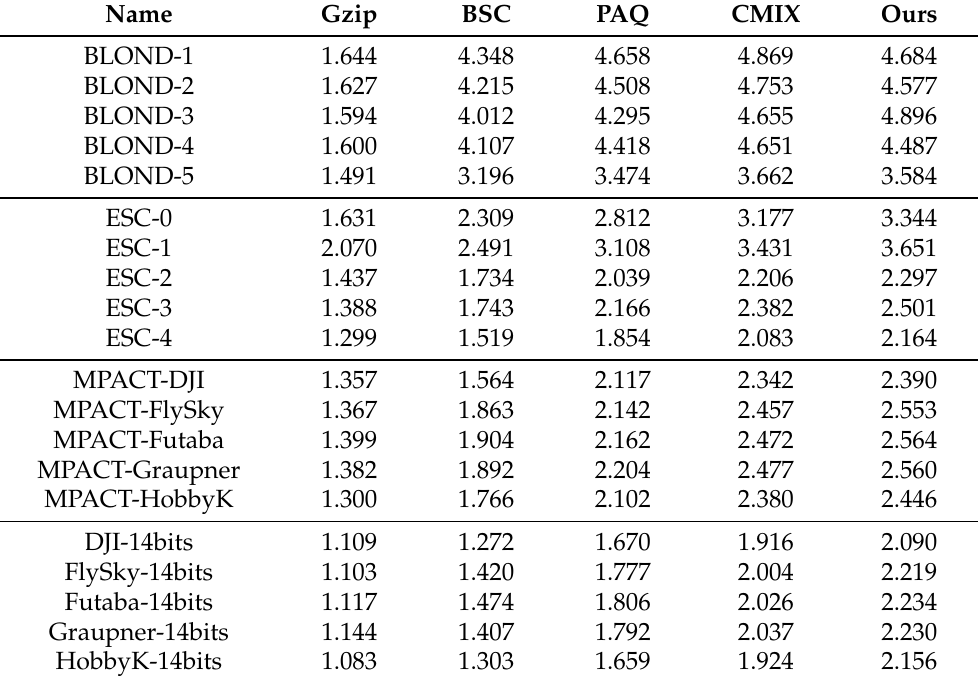
Figure 1. Working flow of a context-based lossless compressor with a probability predictor and an entropy-coding module. Table 1. The CR results of the tested